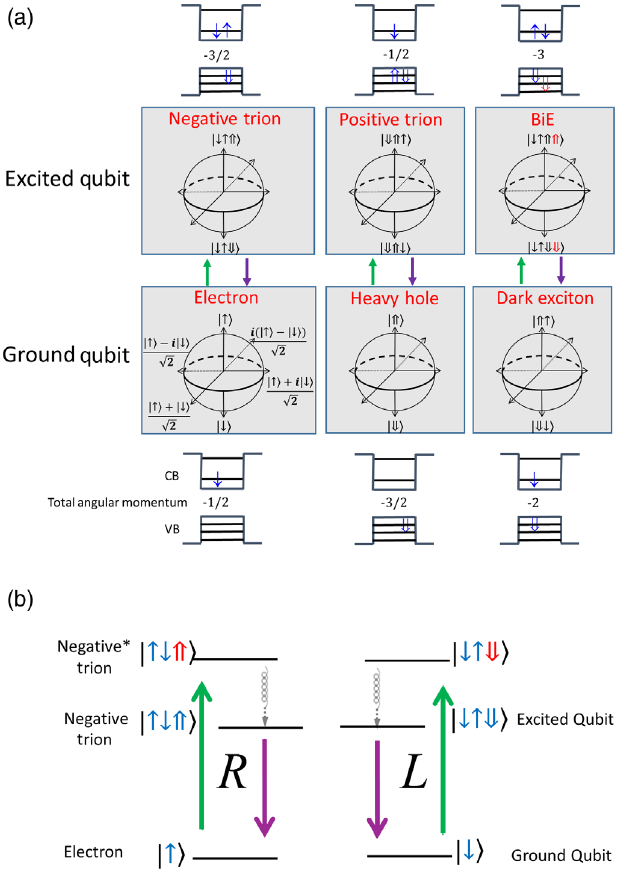
FIG. 1. (a) Spinwave functions and Bloch-sphererepresentations of the six matter spin qubits used in this work. The six qubits, represented by their Bloch spheres, are divided into three pairs of ground and excited-level qubits. The spin wave functions of the ground-level (excited-level) qubits are schematically described below (above) the respective Bloch spheres, where ↑ ( ⇓ ) represents spin-up electron (down heavy hole), and the blue (red) color represents a carrier in its ground (excited) energy level. Green upwardarrowsrepresentlaserpulseswhichconverttheground-level qubittoitsrespectiveexcited-levelqubit.Magentadownwardarrows represent single photons emitted from the excited qubits thereby returning to the ground-level qubit. (b) The optical transitions and polarizationselectionrulesfortheelectron-trionsystem,whichform aground-level – excited-levelqubitpair.Notethatinthis example(as in all other cases) an optical Π system is described, but the exciting laser pulse is tuned to an excited trion level, in order to facilitate polarization tomographyofthe emitted photon(magenta downward arrows) byspectrally separating the emissionfrom the exciting laser pulse (green upward arrows). The fast (about 70 ps [29]) phonon- assisted relaxation of the excited trion to the ground trion level is represented by gray curly downward arrows. The right-hand (left- hand) circular polarization of the photons which connect the 1 = 2 ( − 1 = 2 ) spin state of the ground-level qubit with the þ 3 = 2 ( − 3 = 2 ) spin state of the excited qubit are marked by R ( L